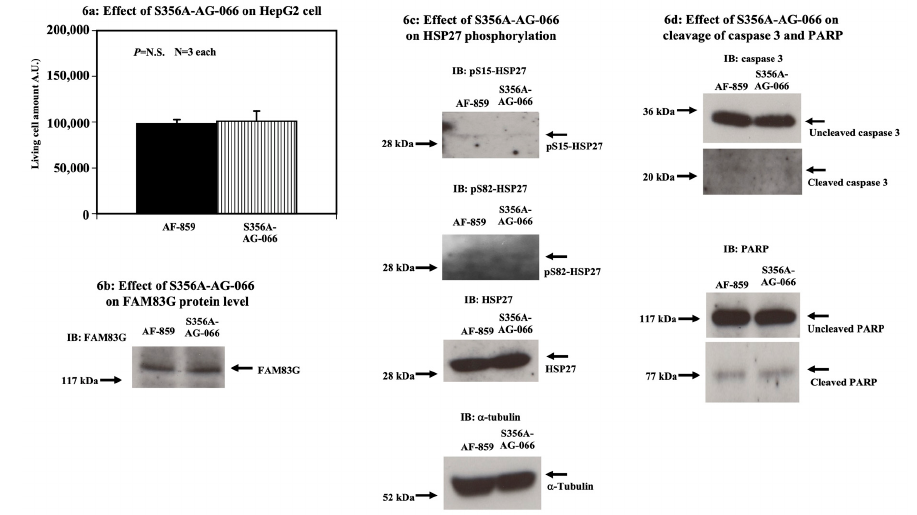
Figure 6. The effect of the FAM83G S356A-AG-066 peptide on apoptosis in HepG2 cells. ( a ) S356A-AG-066 does not affect the live HepG2 cell number. The effects of S356A-AG-066 (right column) and AF-859 (left column) (both 54 μ M) on live HepG2 cells numbers were not significantly different. The experiments were independently performed in triplicate. ( b ) S356A-AG-0666 does not affect FAM83G protein levels. Immunoblots show that the peptides AF-859 and S356A-AG-066 had no effect on endogenous FAM83G protein levels. The experiments were independently performed in triplicate. ( c ) Effect of S356A-AG-066 on HSP27 phosphorylation. Whole cell lysates from HepG2 cells treated with either AF-859 or S356A-AG-066 were analyzed by immunoblotting (IB) with antibodies specific for anti-phospho-(S15) HSP27 (top panel, left) and anti-phospho-(S82) HSP27 (second panel down). IB with an HSP27-specific antibody showed that the S356A-AG-066 treatment of HepG2 cells did not affect HSP27 protein levels relative to AF-859 (third panel down); thus, S356A-AG-066 did not affect S15 and S82 phosphorylation in HepG2 cells. The experiments were independently performed in triplicate. ( d ) S356A-AG-066 does not cause apoptosis in HepG2 cells (cleavage of caspase 3 and PARP proteins). HepG2 cells treated with S356A-AG-066 showed no change in both caspase 3 and PARP protein cleavage relative to AF-859-treated HepG2 cells. Top two panels: levels of cleaved (second panel down) and uncleaved (top panel) caspase 3 proteins (arrow) following the treatment of HepG2 cells with AF-859 (left lane) and S356A-AG-066 (right lane). Bottom two panels: levels of cleaved (second panel down) and uncleaved (top panel) PARP proteins (arrows) following the treatment of HepG2 cells with AF-859 (left lane) and S356A-AG-066 (right lane). The positions of the uncleaved and cleaved PARP proteins are shown by arrows (right side). Bottom panel: α -tubulin immunoblotting shows equivalent protein loading in each lane (strip and re-probe technique was applied). The experiments were independently performed in triplicate.